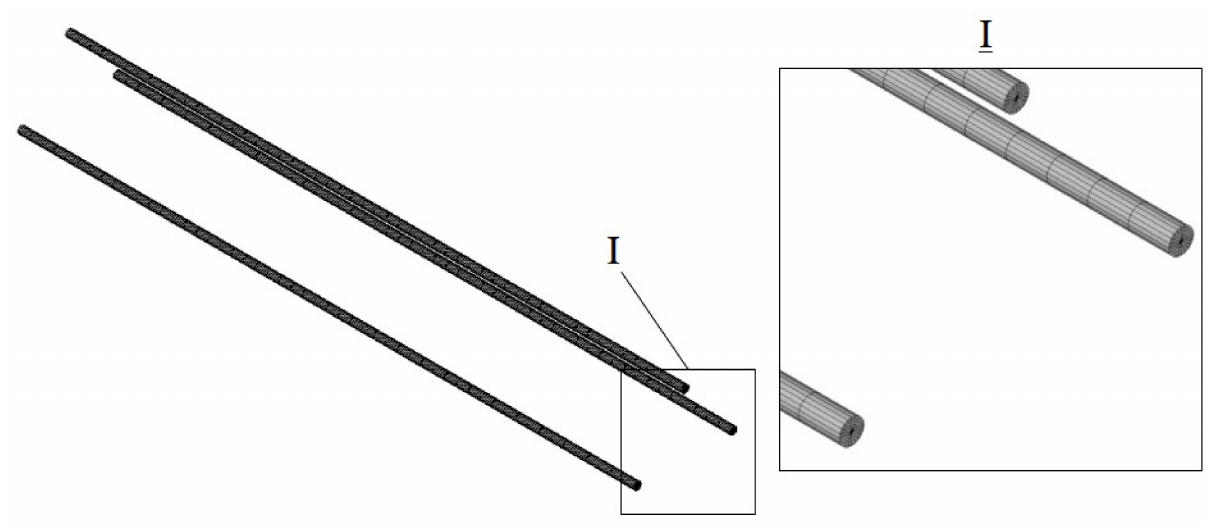
Figure 4. Reinforcement